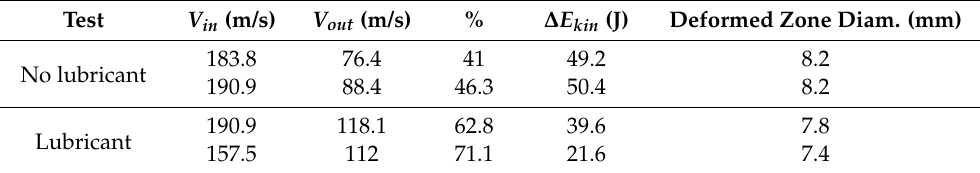
Table 2. Comparison of puncture test results with and without lubricant in the impact area.